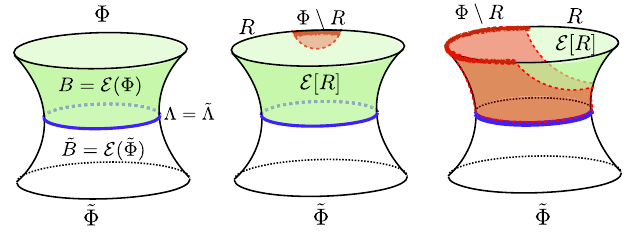
FIG. 2. The left diagram illustrates the thermofield double construction, in which a bulk manifold B with logical boundary Λ is extended to two copies of B with their logical boundaries ~ B identified. This doubled manifold B describes two holographic codes whose logical systems are maximally entangled. The other two diagrams illustrate that, for a boundary region R contained in the physical boundary Φ of B , the corresponding minimal surface lies in B